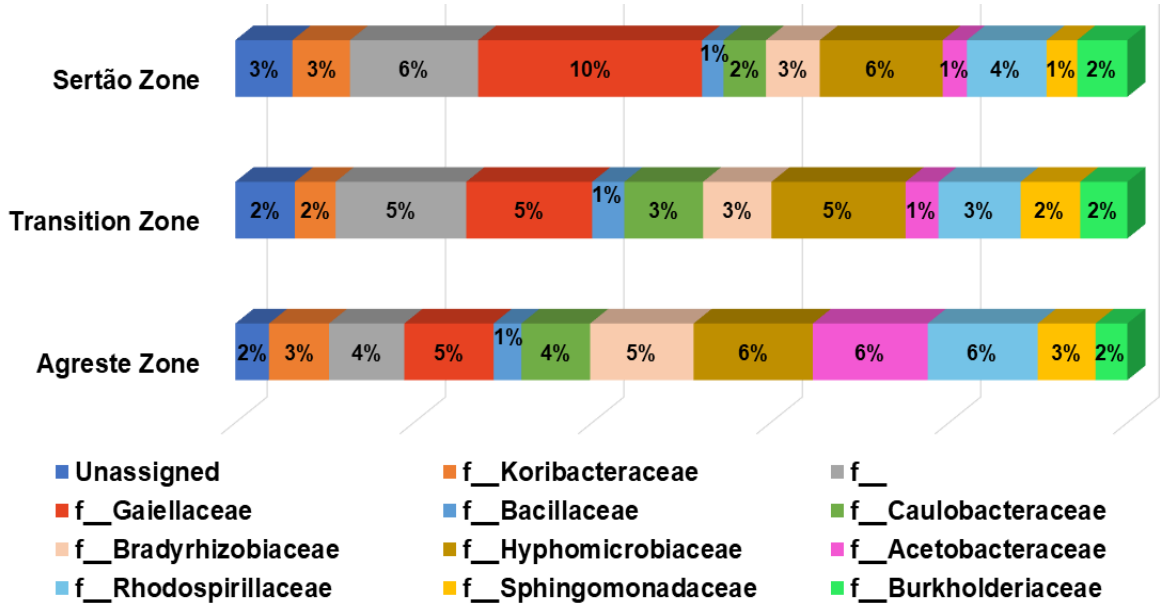
Figure 4. Taxonomic distribution of the microbial community of the soil at the level of family observed in mesoregions the state of